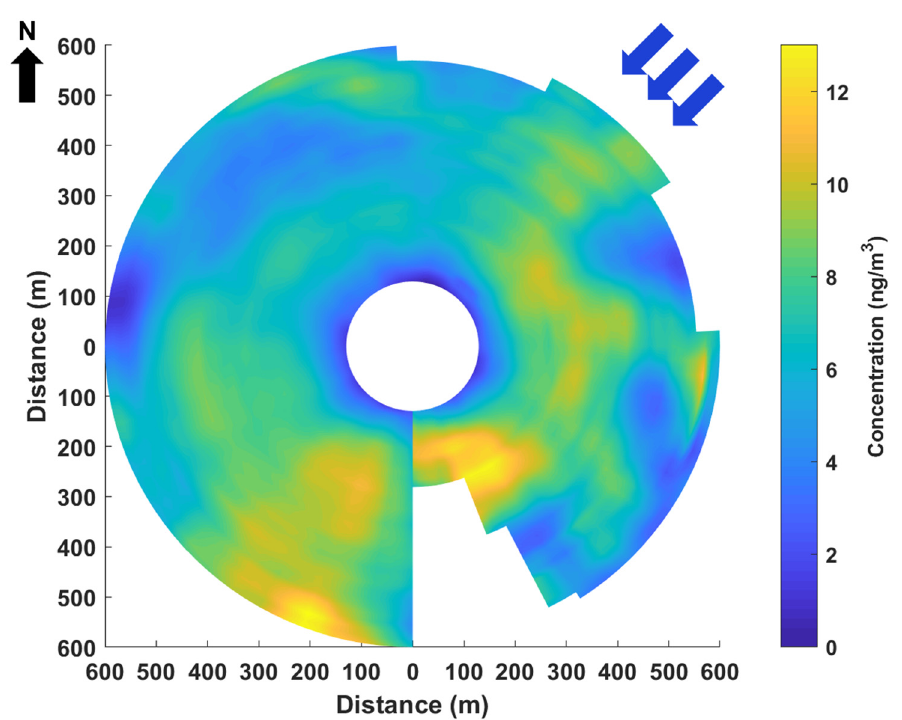
Figure 3. The 360° mapping of mercury concentration from 21:30 August 4, to 6:30, August 5, 2016. Each sector is averaged for 7 min with 60 sectors altogether. The wind direction was from the northeast as indicated in blue arrows. In certain directions, the range covered is more limited; this is particularly true in the south–east direction, where the strongly increased light background level due to the early morning sun impaired the available signal-to-noise ratio. The concentrations were measured along the laser beam, which had an elevation of about 5 degrees corresponding to 10–55 m height for the 100–600 m range. The concentration value range resolution was 75 m.